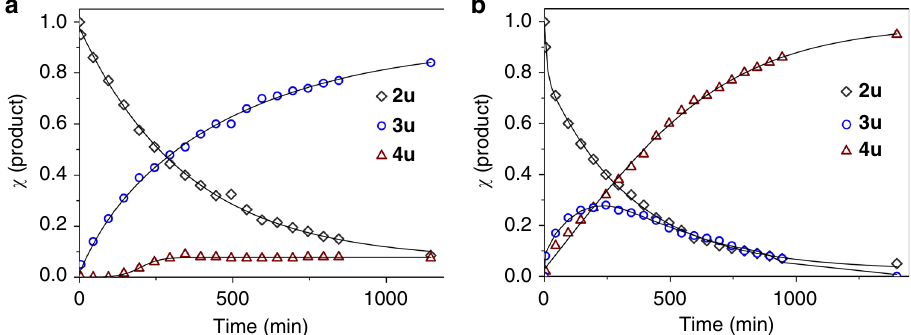
Fig. 6 Reaction pro fi les. a Catalytic transfer hydrogenations of 6-methylquinoline ( 2u ) with one equiv of H 3 N·BH 3 . b 2u with two equiv of H 3 N·BH 3 . Conditions: [ 2u ] = 0.32 M, [ 1 ] = 0.0016 M, [H 3 N·BH 3 ] = 0.35 M for ( a ) and 0.70 M for ( b ) in THF- d 8 at 25 o C.